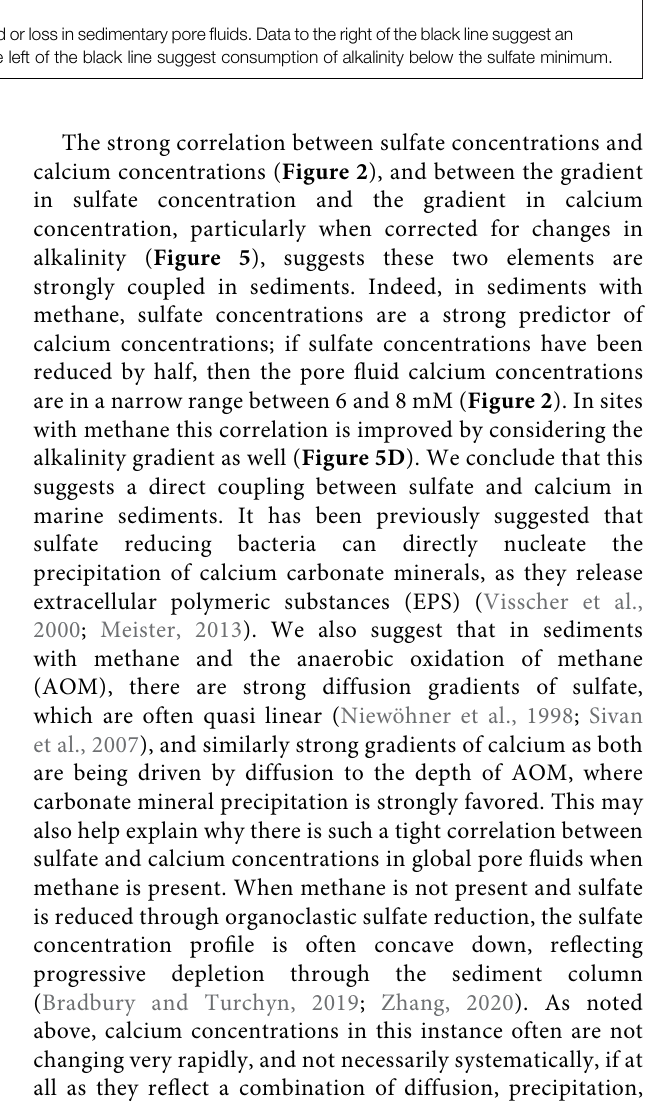
Frontiers in Earth Science |